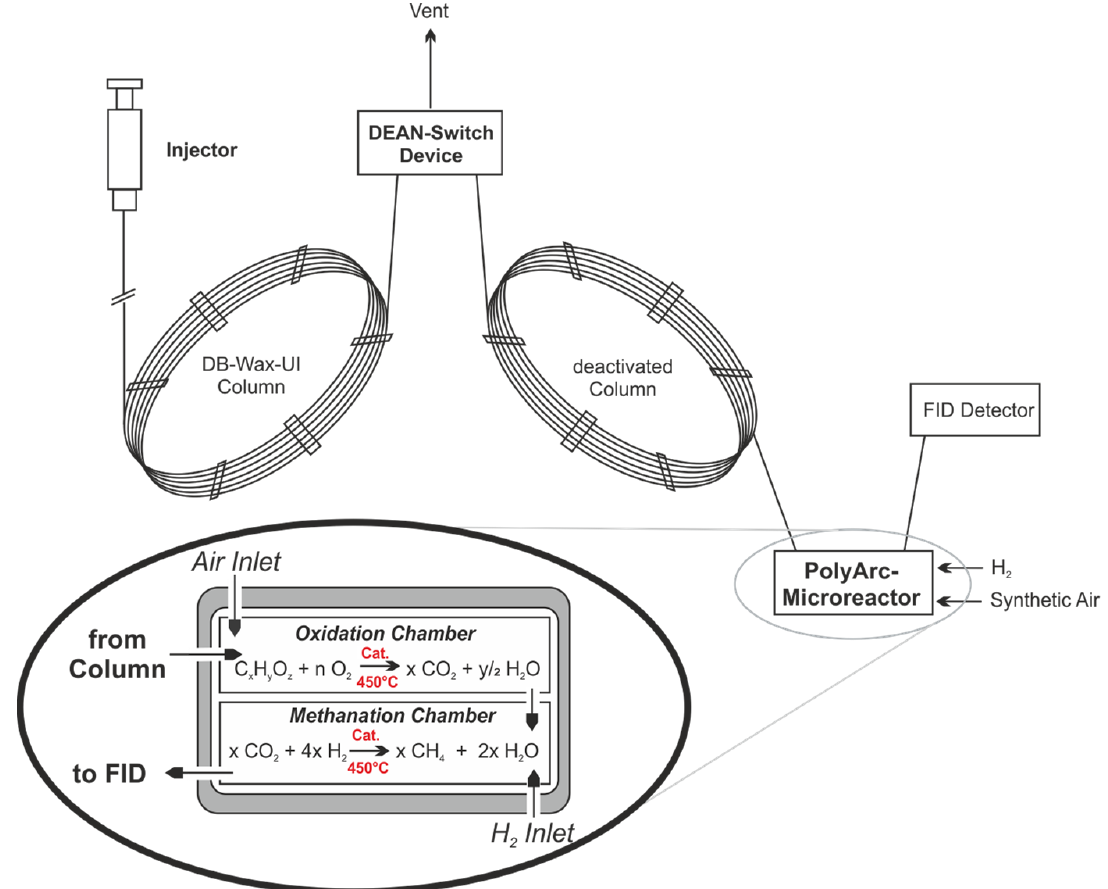
Figure 14. Working principle of the optimised GC analytics with protecting Dean switch and the catalytic two-chamber micro reactor for methanisation of analytes (PolyArc) [49,50] .